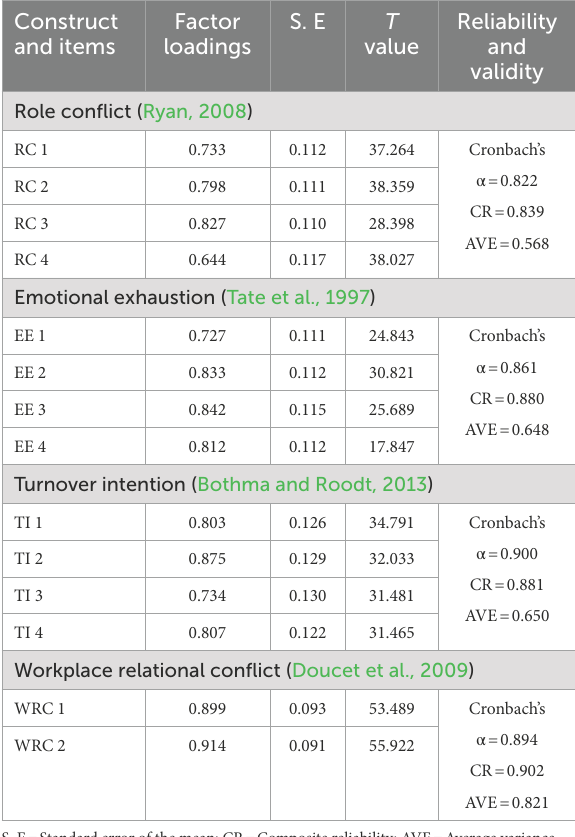
TABLE 2 Construct reliability and validity analysis.